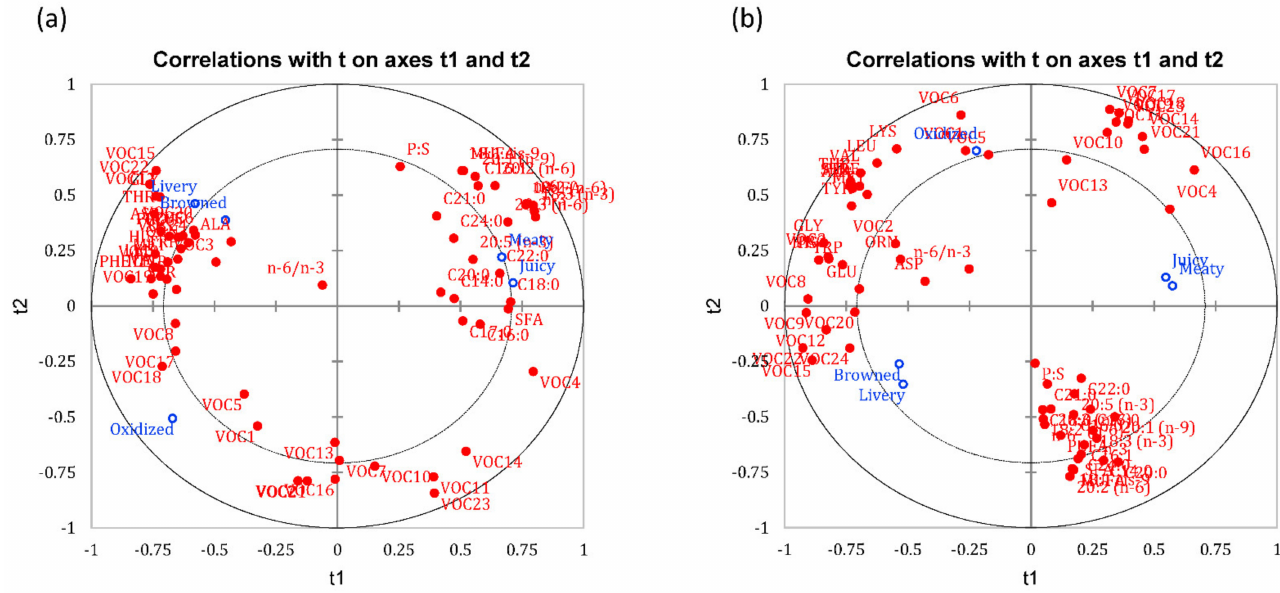
Figure 6. ( a ) Correlation biplots of Partial Least Square Regressions (PLSR) models for PEF treated chilled samples representing fatty acids, amino acids, and volatile composition in relation to sensory attributes. ( b ) Correlation biplots of PLSR models for PEF treated frozen samples representing fatty acids, amino acids, and volatile composition in relation to sensory attributes. VOC codes for Figure 6a correspond to Supplementary Table S2 for chilled samples, and codes in Figure 6b correspond to Supplementary Table S3 for frozen samples. Exploratory variables with VIP less than 1 are omitted for